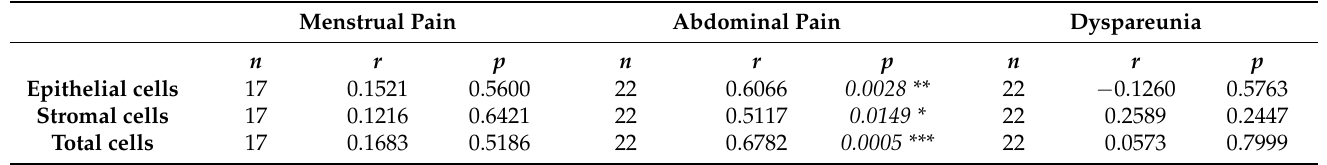
Table 3. Correlation between automated cell counts and pain